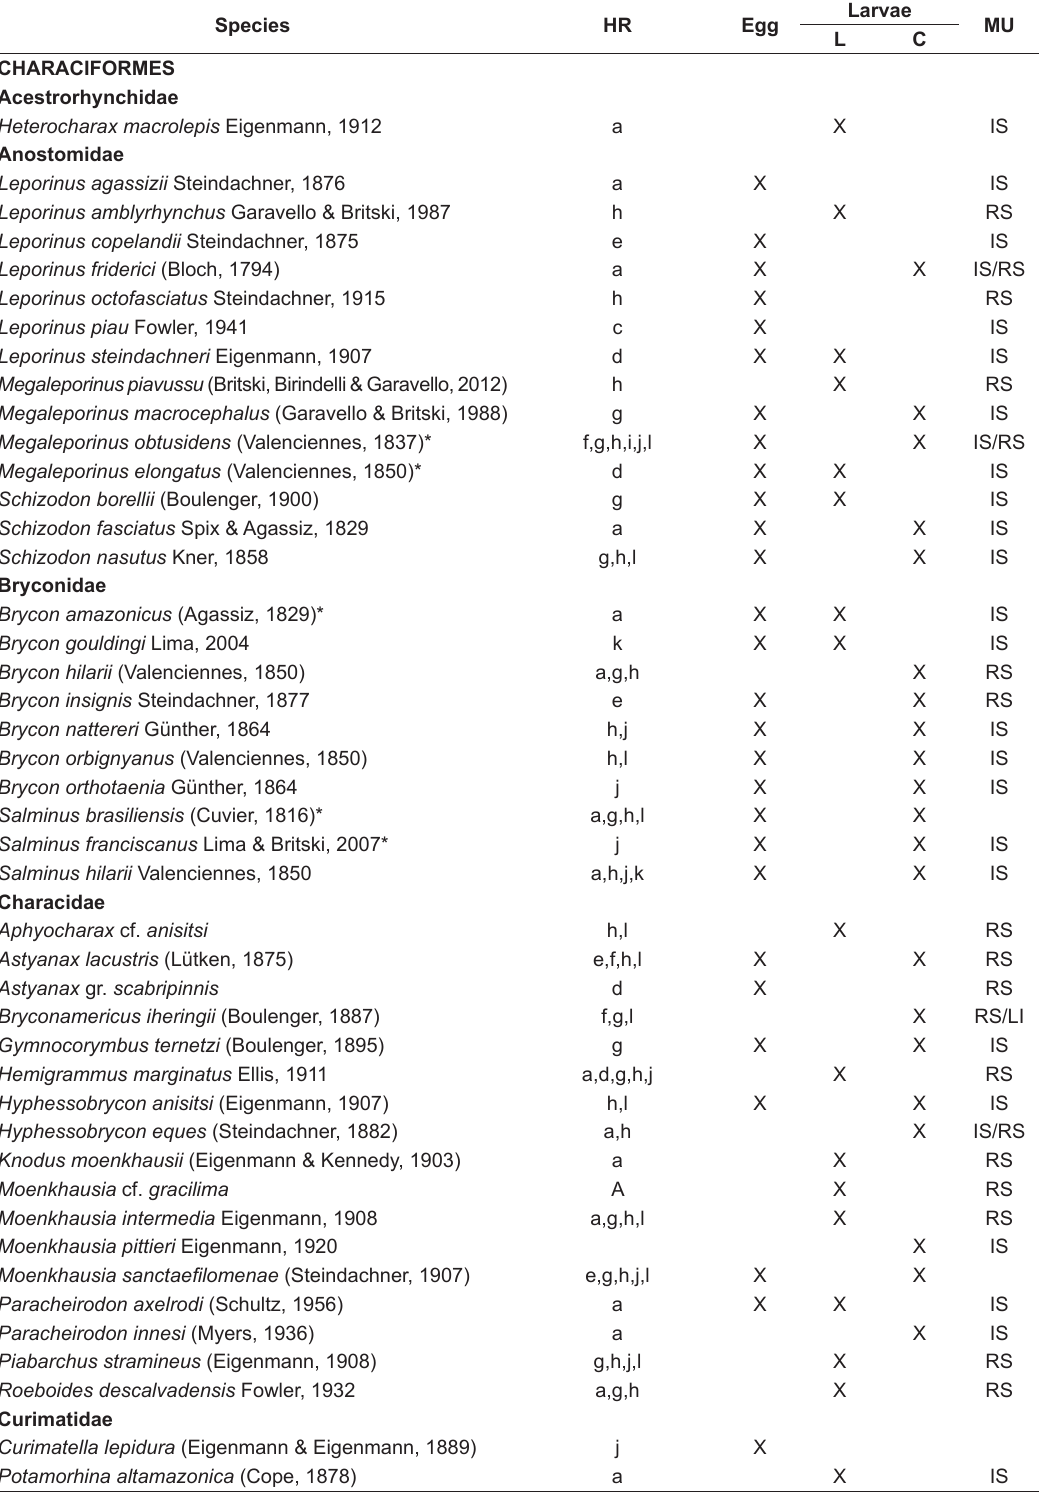
HR: Hydrographic region of origin, a = Amazon, b = Western Northeast Atlantic, c = Eastern Northeast Atlantic, d = East Atlantic, e = Southeast Atlantic, f = South Atlantic, g = Paraguay, h = Paraná, i = Parnaíba, j = São Francisco, k = Tocantins-Araguaia and i = Uruguay; Larvae, I = Incomplete, without all larval stages and C = Complete, with all larval stages; MU = Methodology used to obtain the collection, RS = regressive series, IS = induced spawning and LI = live ichthyoplankton *commercial